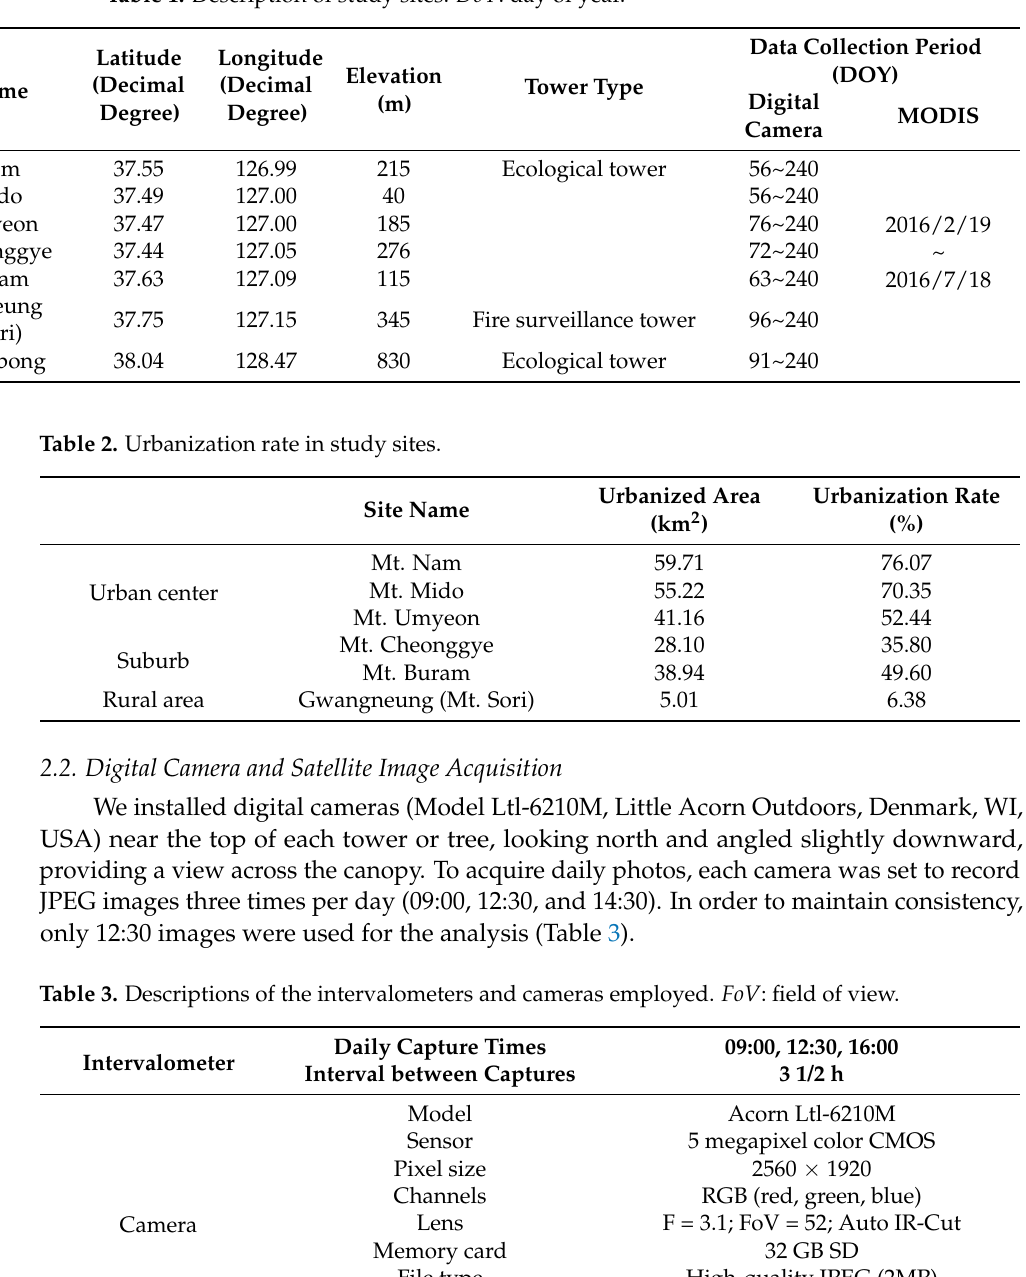
Table 1. Description of study sites. DoY : day of year.